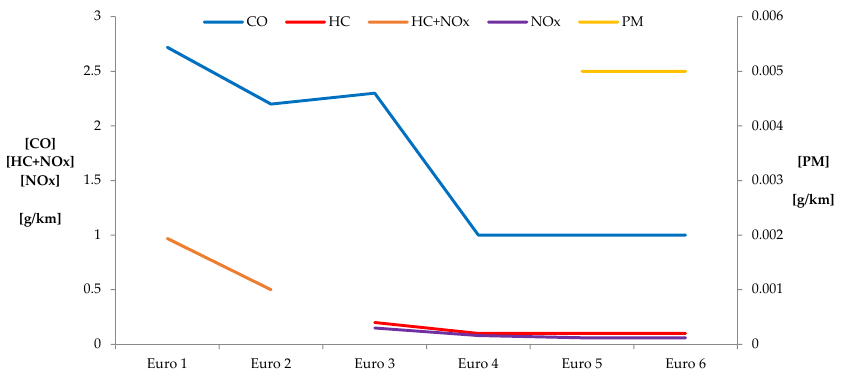
Figure 2. The Euro emission standards for the regulated pollutants for petrol passenger cars (based on [16]).